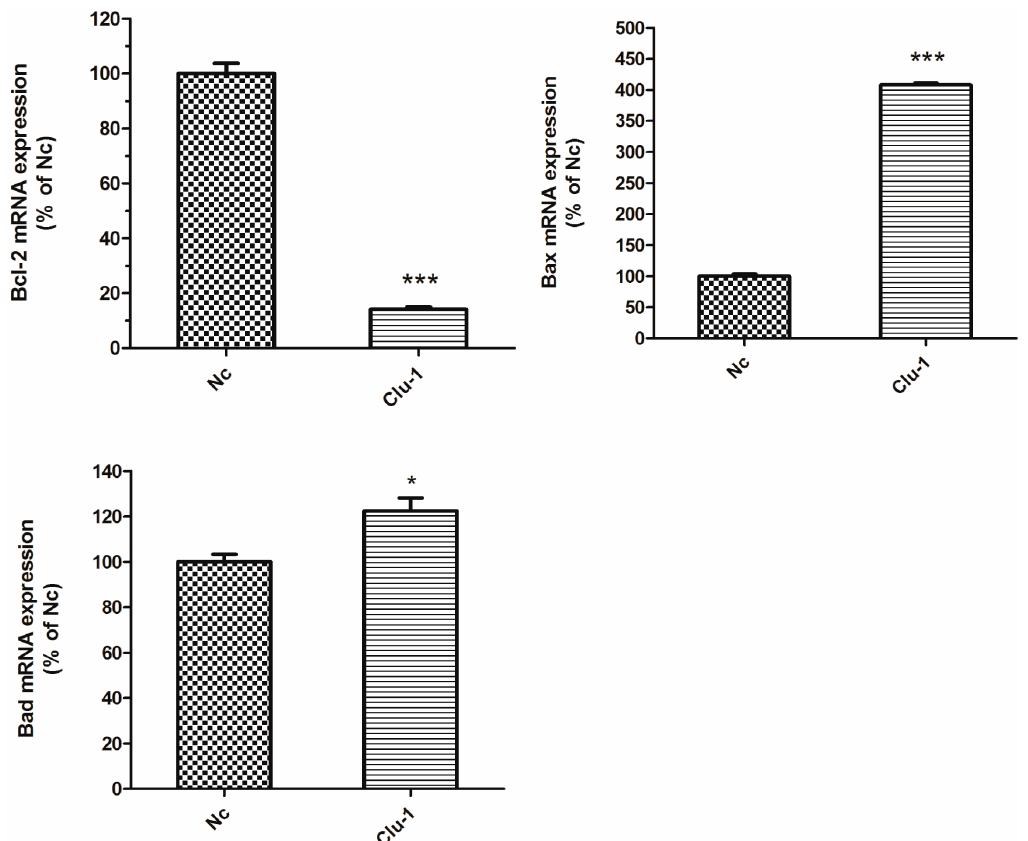
Figure 4. Altered expression levels of apoptosis-related genes Bax , Bcl-2 and Bad in the Clu -knockdown SH-SY5Y cells. Real-time PCR was used to detect the mRNA